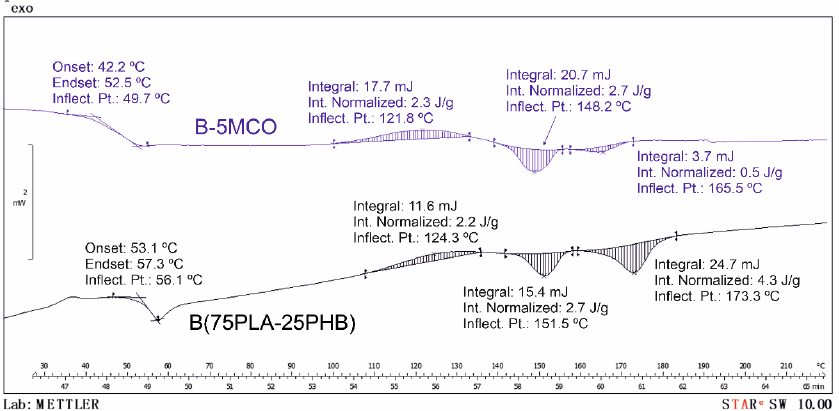
Figure 4. Calorimetric graphs of samples B (PLA – PHB) and B-5MCO.